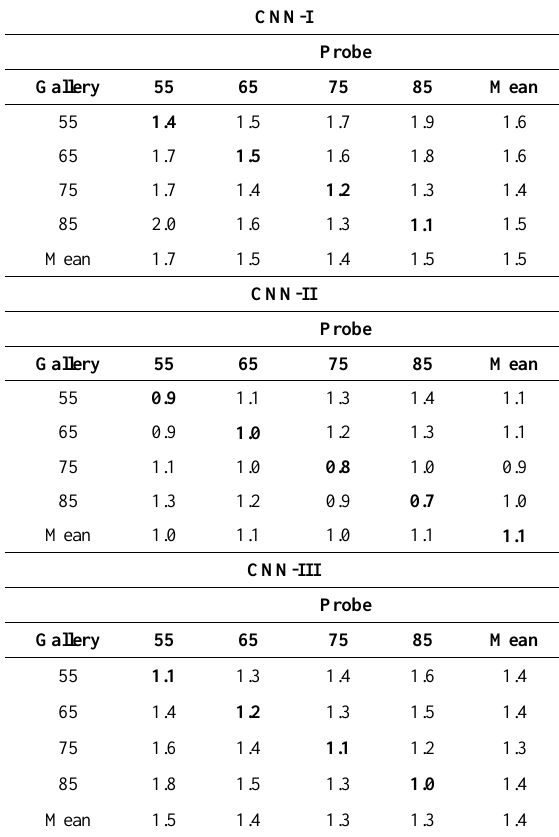
Table 5. Equal Error Rate for OUISIR-MVLP